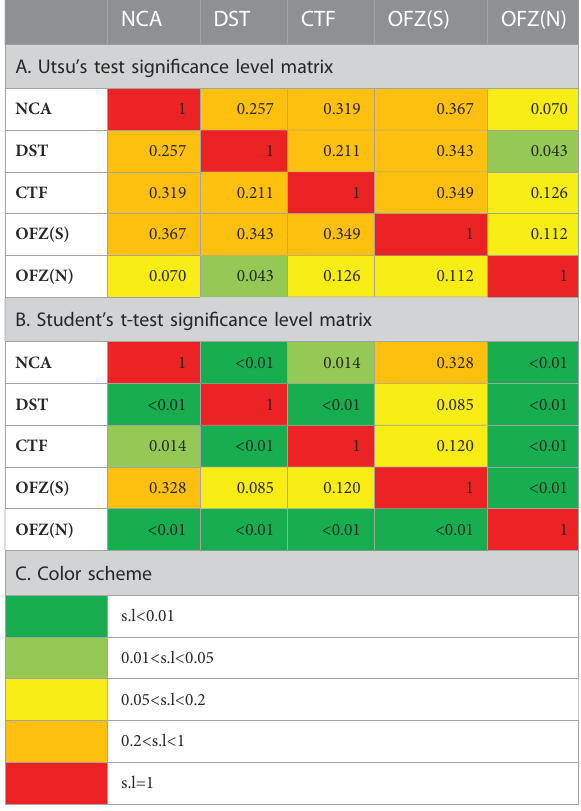
for one pair (DST ←→ OFZ(N)) does not indicate statistical signi fi cance, the Student ’ s t-test shows that seven out of 10 pairs are signi fi cantly different from each other, with s . l . ≤ 0 . 05 . The stages of calculation for the t-test are provided in the Tables A3 and A4 of the Supplementary